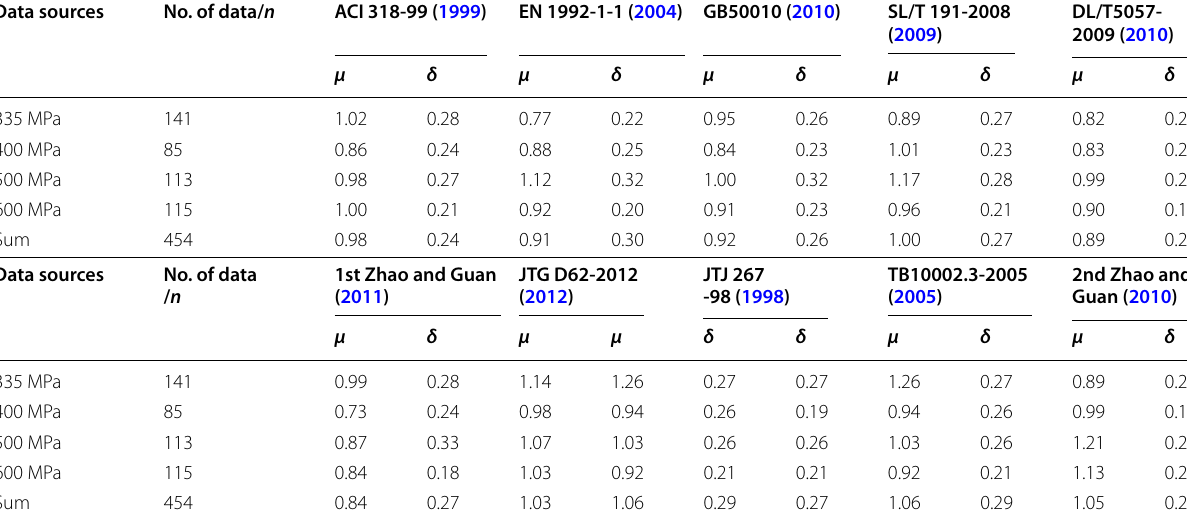
Table 8 Comparison of experimental w t max with calculated w c max by different codes and methods. Data